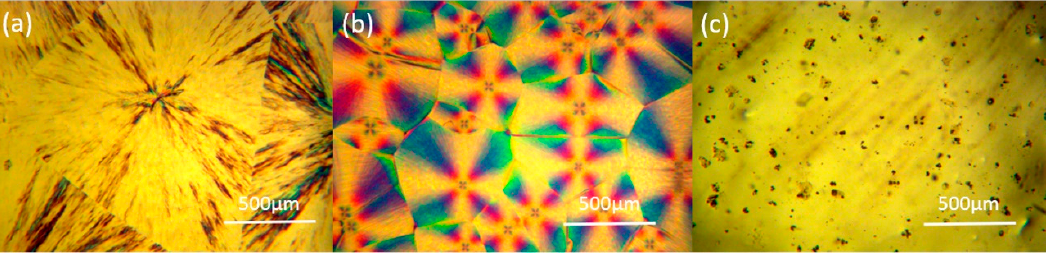
Figure 5. Polarizing optical microscopy (POM) micrographs of PEG6000 ( a ), SPU ( b ) at room temperature, and SPU at 60 °C ( c ).